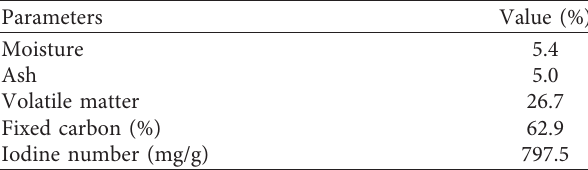
Table 2: The proximate and iodine number analysis for CISAC.